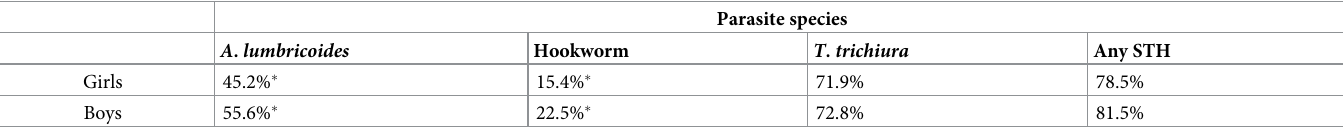
Table 3. Proportions of boys and girls infected with different species of